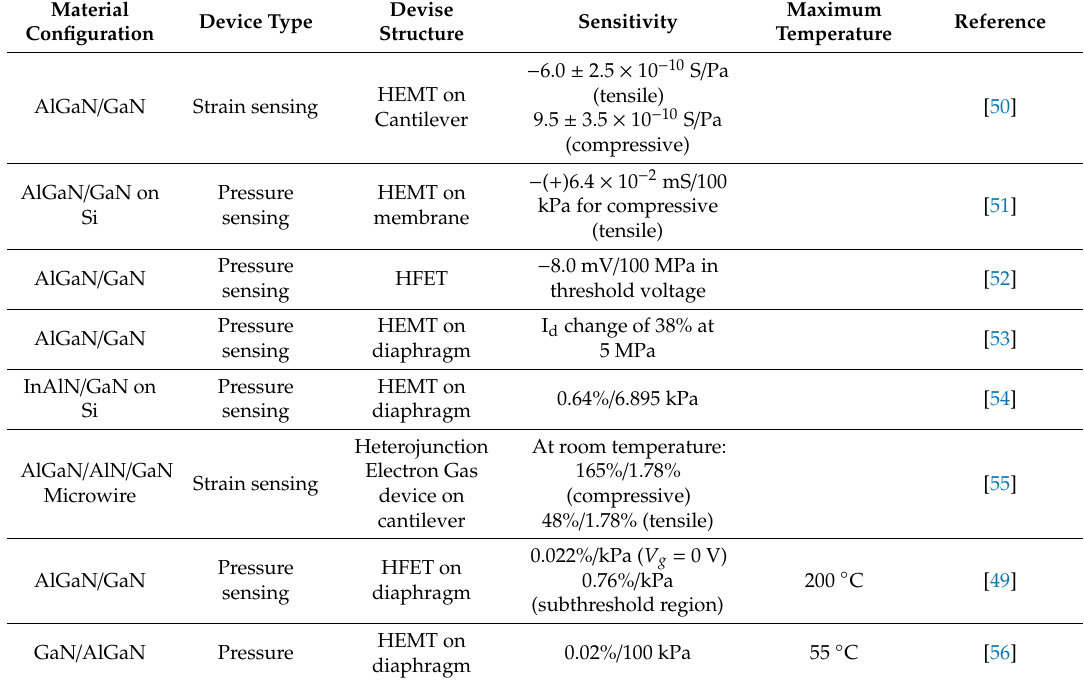
Table 7. A comparison of GaN-based thin-film pressure and strain